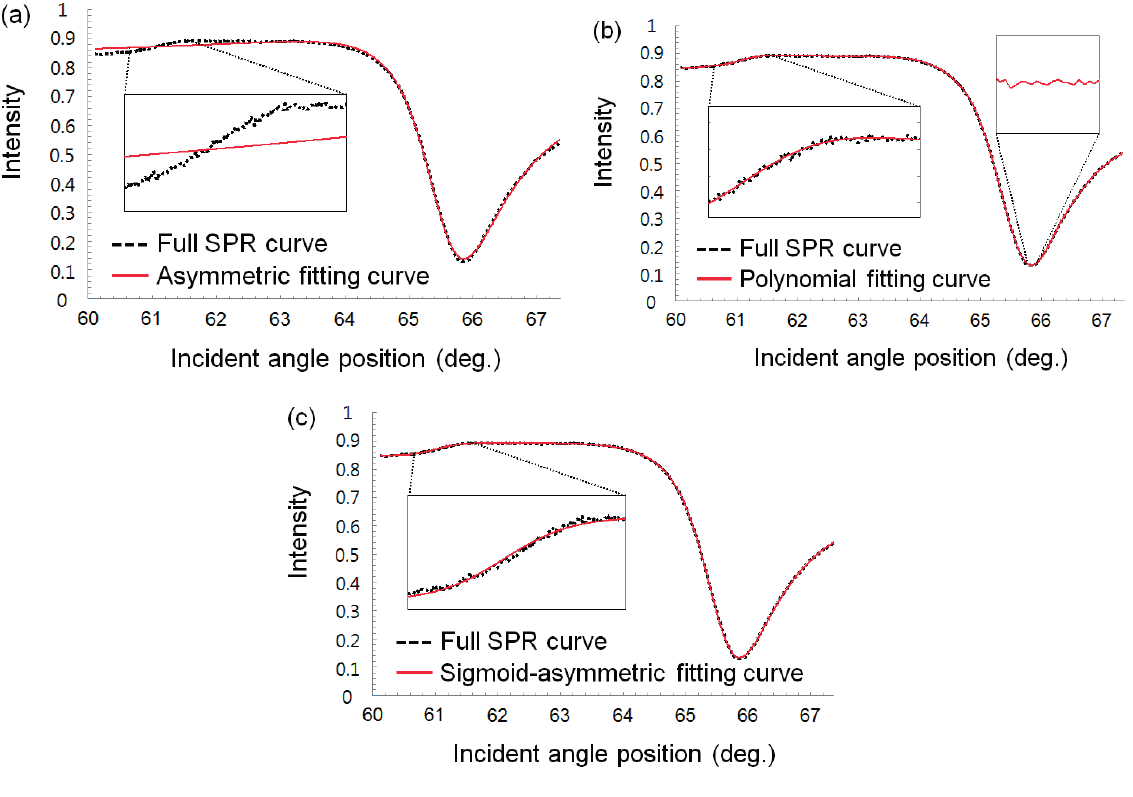
Figure 5. SPR curve-fitting results measured in water (black dot line: SPR curve, red solid line: fitting curve): ( a ) Asymmetric fitted SPR curve. ( b ) 24th-order polynomial regression-fitted SPR curve. ( c ) Sigmoid-asymmetric fitted SPR